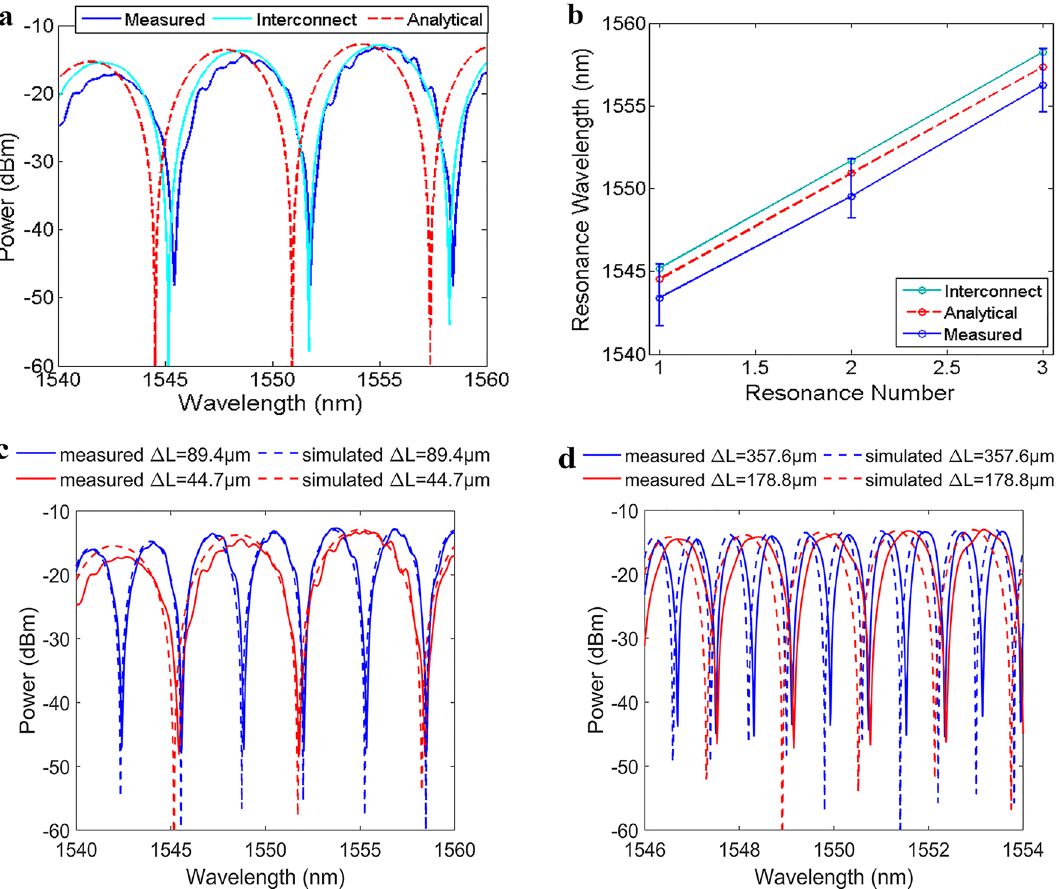
Figure 4. Comparison of the: ( a ) output power versus wavelength and, ( b ) resonance wavelengths from measured, Interconnect and analytical modelling of the LT-aMZI with ΔL = 44.7 µm. The measured (solid) and simulated (dotted) output power spectra versus wavelength of the LT-aMZI designs with path length differences: ( c ) ΔL = 44.7 µm (red) and ΔL = 89.4 µm (blue) and ( d ) ΔL = 178.8 µm (red) and ΔL = 357.6 µm (blue).